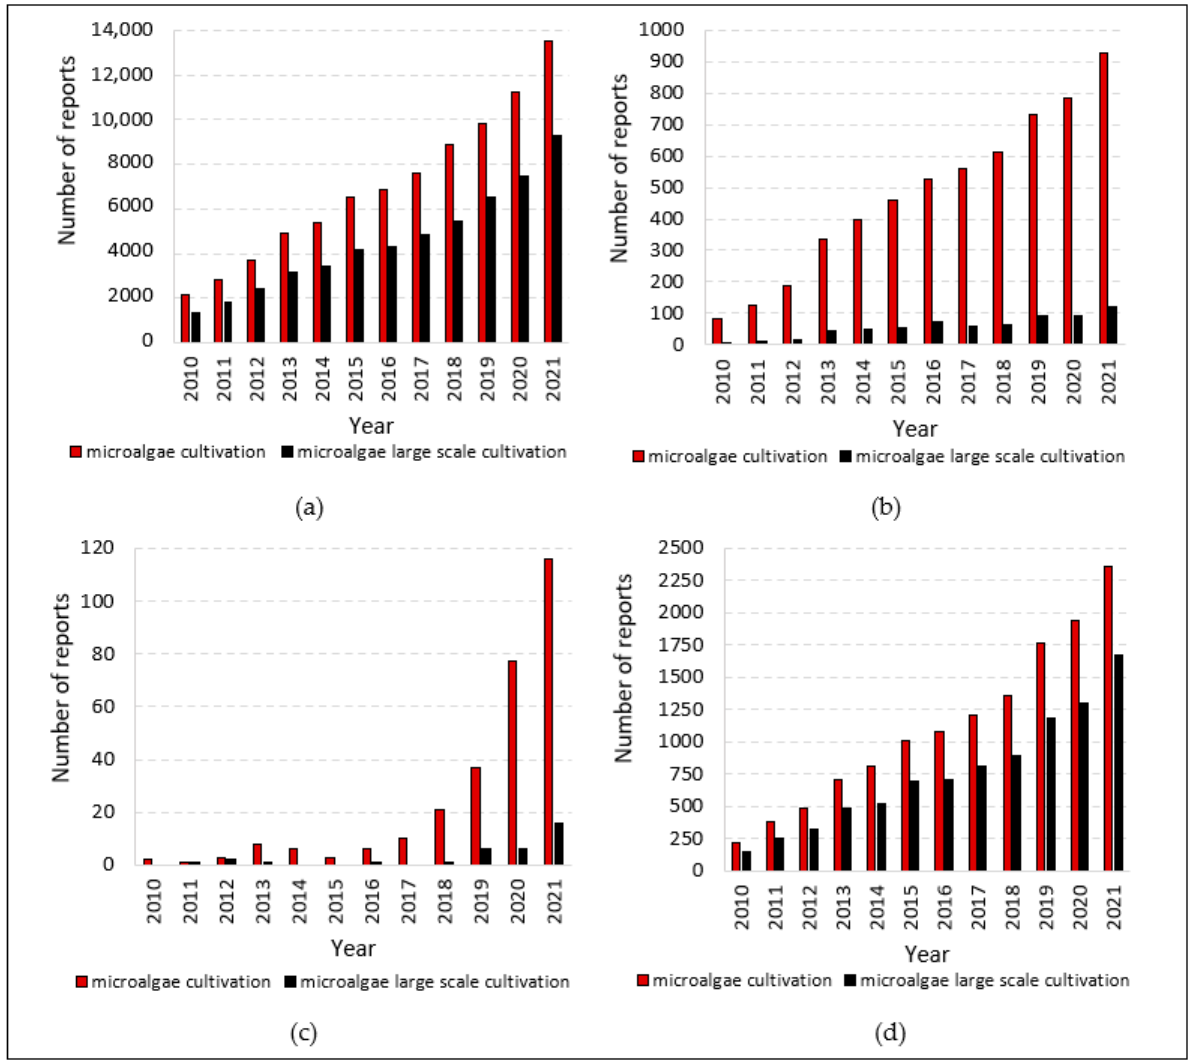
Figure 6. Article results in ( a ) Google Scholar, ( b ) Scopus, ( c ) MDPI and ( d ) Science Direct between 2010 and 2021 for the keywords “microalgae cultivation” and “microalgae large scale cultivation”. Accessed 24 October 2022.